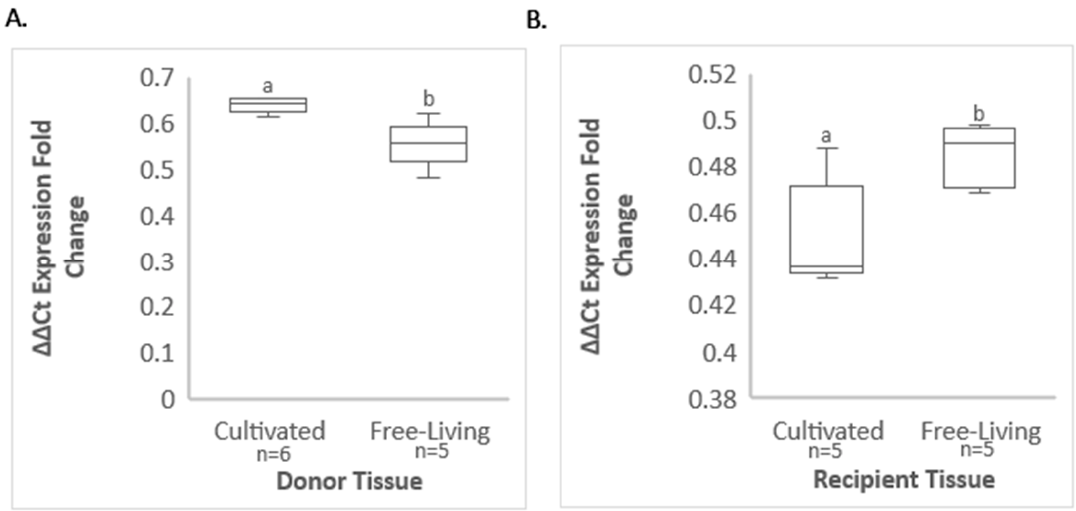
Figure 4. Quantification of grapevine red blotch virus (GRBV) by qPCR in ( A ) donor Vitis californica